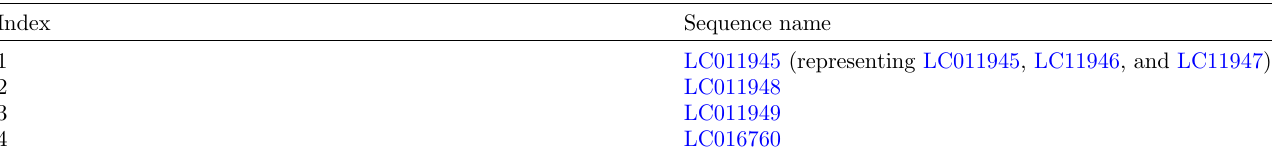
Table 2. Genomic sequences and index number. The original set of six genomic sequences (Table 1) was reduced to four genomic sequences.